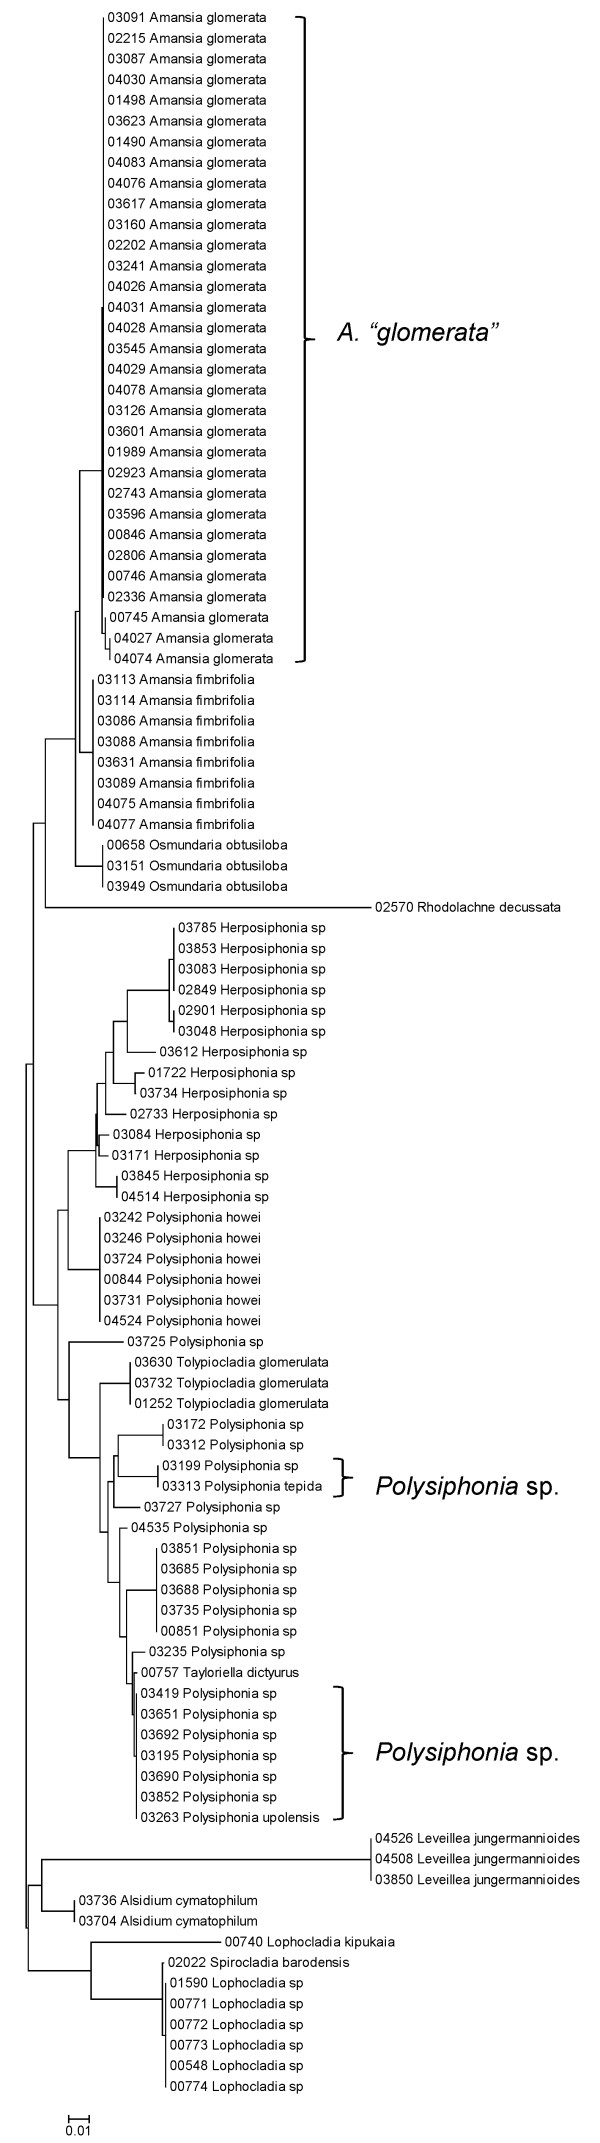
Neighbor-joining tree of LSU sequences of the family Rhodomelaceae (part 2) of the order Ceramiales. Sequence diversity based on the COI mitochondrial marker for surveyed Rhodophyta specimens belonging to the family Rhodomelaceae (excluding the Laurencia complex) of the order Ceramiales. Neighbor-joining tree is based on the Maximum Composite Likelihood nucleotide model in MEGA 4.0. Scale bar = substitutions per site.